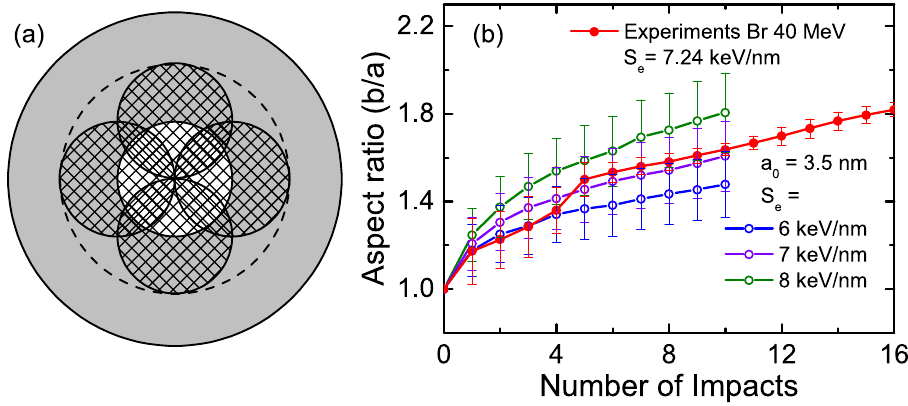
Figure 5. ( a ) Schematic representation of the NP region where the ion impacts produce a meaningful elongation. ( b ) Evolution of the aspect ratio as a function of the number of impacts. Solid symbols represent the experimental results and open symbols the MD